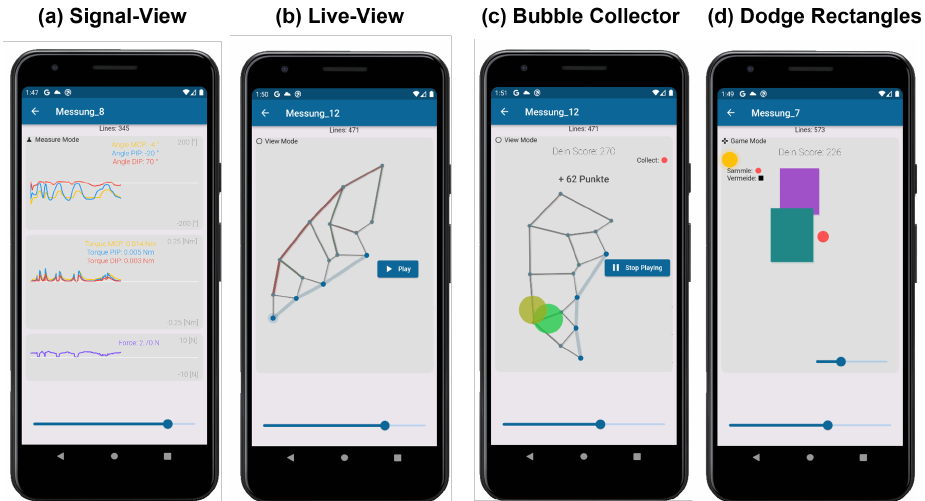
Figure 3. Application details. The general signals of the exoskeleton are displayed in ( a ) and the actual position of the exoskeleton in ( b ). To motivate the patient, the games “bubble collector” in ( c ) and “dodge rectangles” in ( d ) are